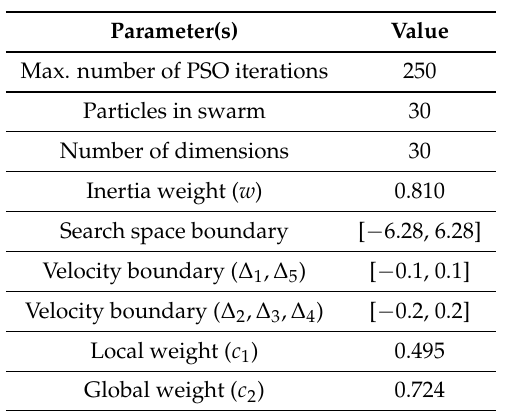
Table 1. PSO parameters involved in all